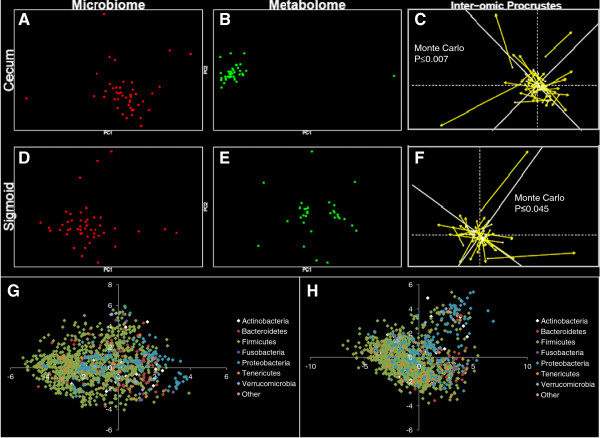
Principal component, Procrustes and coinertia analysis. The first column of plots contains microbiome data (red spots) and the second column contains metabolome data (green spots). The first row contains cecal data and the second row contains sigmoid data. Principal component analysis was performed on the cecum microbiome (A), cecum metabolome (B), sigmoid microbiome (D) and sigmoid metabolome (E). Inter-omic (C and F) Procrustes analysis was then performed. Longer lines on Procrustes plots indicate more within-subject dissimilarity of the microbiome and metabolome. Significance values shown were calculated using the protest function from the vegan R package, which performs repeated symmetric Procrustes analysis to estimate significance. (G) and (H) show operational taxonomic unit (OTU)-level coinertia analysis. Individual OTUs are plotted based on their cointeria-predicted covariance with the metabolome from the cecum (A) and sigmoid (B). To reduce noise in this visualization, the data were thresholded such that only OTUs measured above background in ≥18% of samples are shown. Distance from the center is indicative of the strength of covariance.